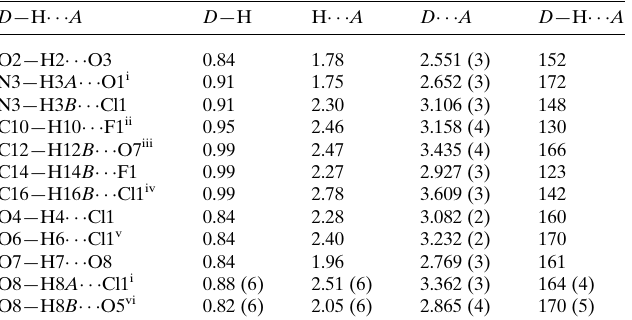
Table 2 Hydrogen-bond geometry (A˚ , (cid:4) ) for